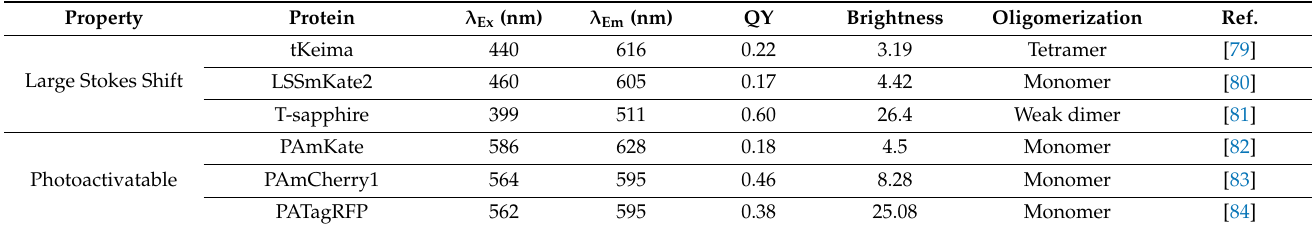
Table 3. Classification of fluorescent proteins based on optical